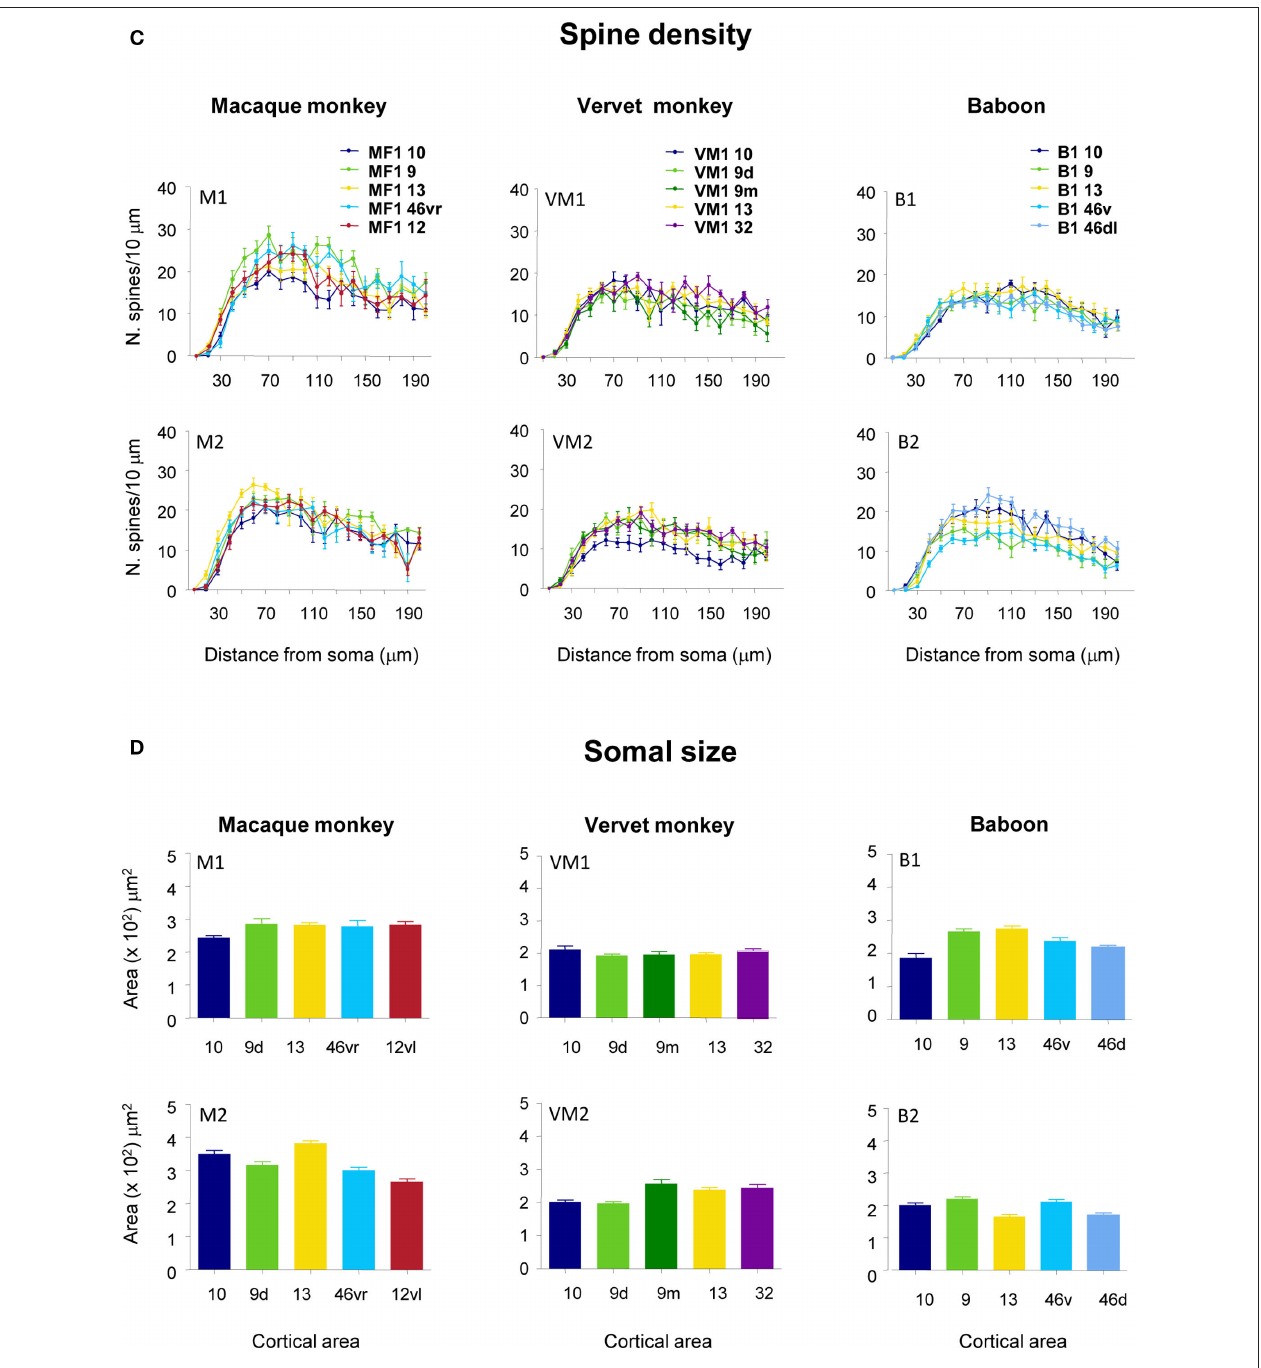
Figure 5 | Frequency histograms and plots of the (A) size, (B) branching patterns, (C) spine density of the basal dendritic trees, and (D) cell body size, of layer III pyramidal neurons sampled in granular prefrontal cortex of the macaque monkey (M1 and M2), vervet monkey (VM1 and VM2) and baboon (B1 and B2). Error bars = standard